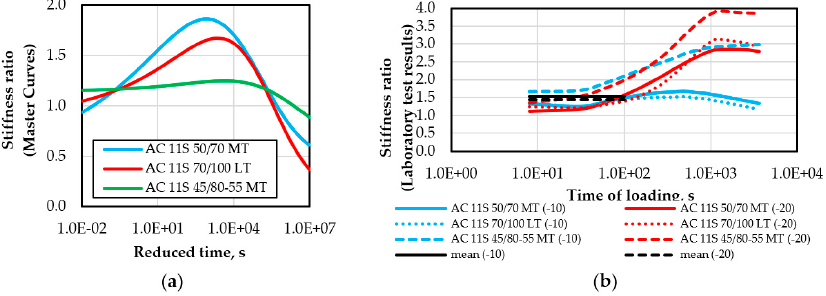
Figure 15. Stiffness ratio (TCT versus BBCT): ( a ) master curves ( b ) stiffness curves at temperatures of − 10 ◦ C and − 20 ◦